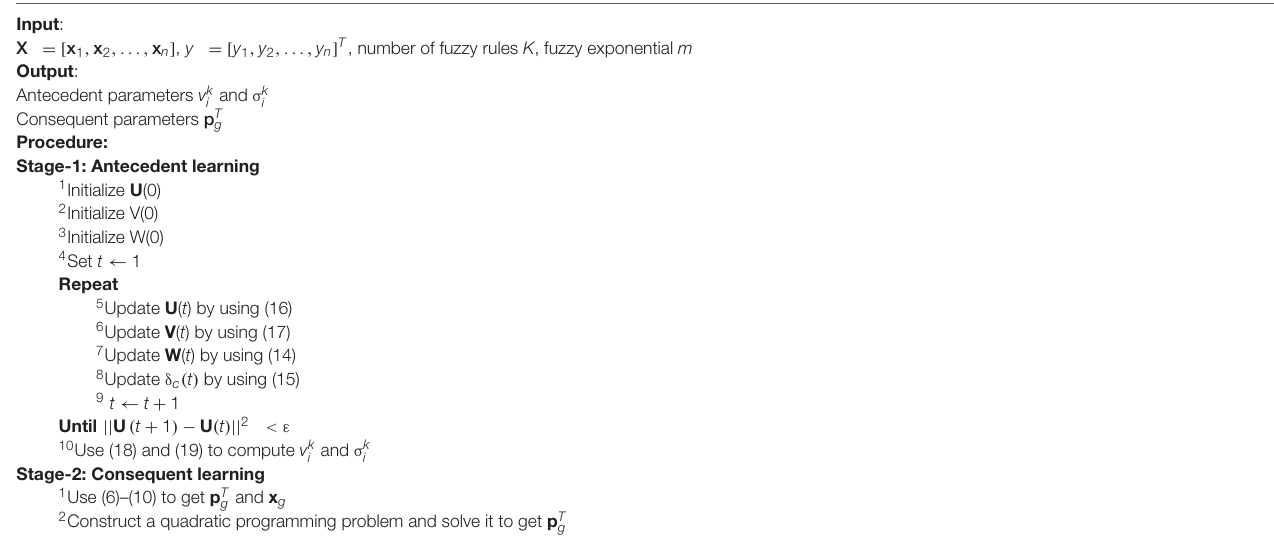
Figure 3B , the number of features involved in each feature is 1, 3, 1, 1, 5, 1, 1, 1, 4, 2, 1, 1, 3, 5, and 1,